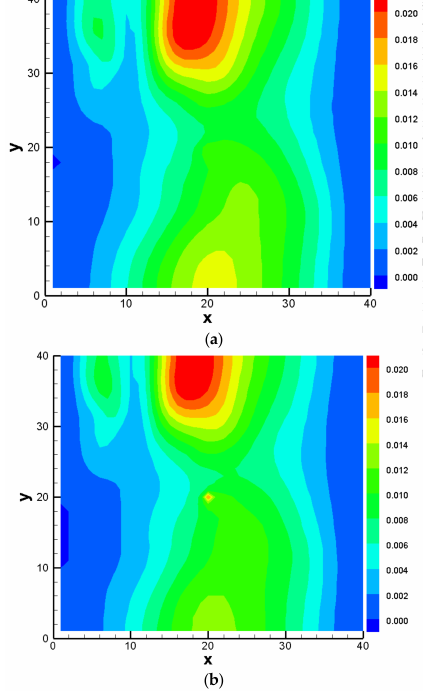
Figure 11. Comparison of model averaged between-model variance based on: ( a ) MC method; ( b ) PCM method.